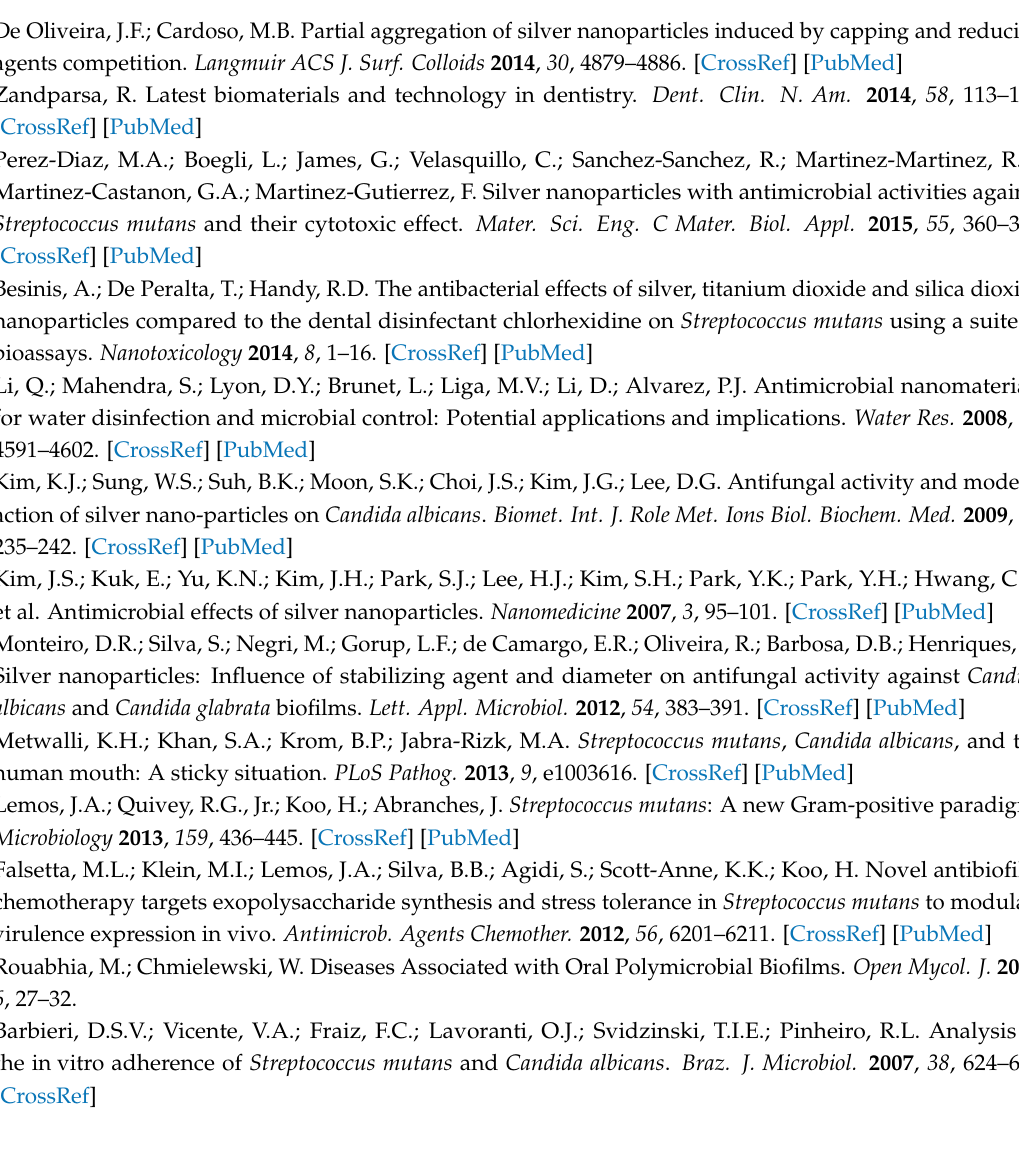
Figure S1: UV–Visible spectrum of Ag-CaGP nanocomposites, Figure S2: X-ray diffraction pattern of Ag-CaGP nanocomposites, Figure S3: TEM images of B4 Ag-CaGP nanocomposite, Figure S4: SEM images and energy-dispersive X-ray sprectroscopy (EDS) mapping in 2D elements issuance Si K α , O K α , P K α ,Ca K α and Ag K α false color. Analysis of the distribution of silver nanoparticles in the Ag-CaGP nanocomposites B1, B2 and B3, Figure S5: SEM images and EDS mapping in 2D elements issuance Si K α , O K α , P K α ,Ca K α and AgK α false color. Analysis of the distribution of silver in the Ag-CaGP nanocomposites B5, B6 and B7, Figure S6: